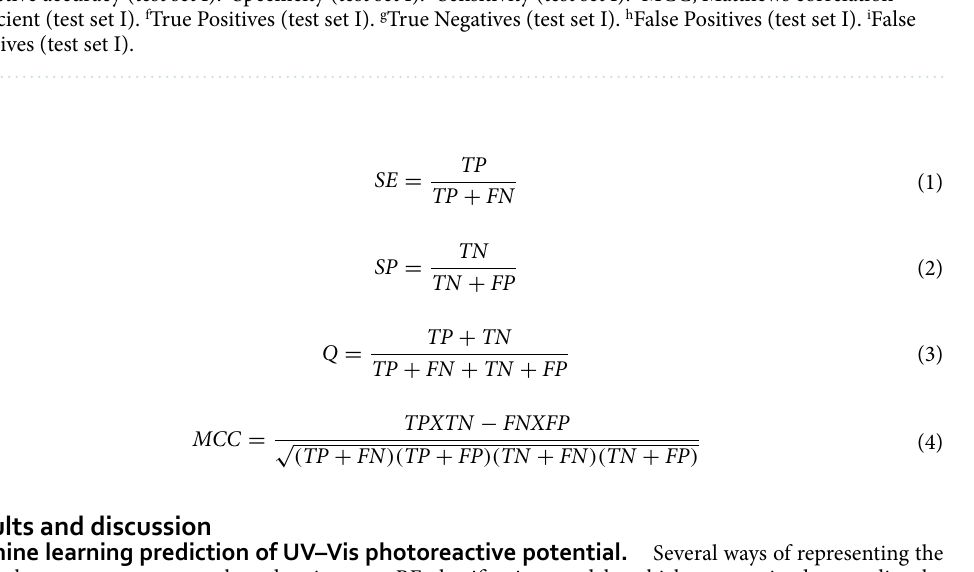
Table 3. Evaluation of different molecular descriptors and fingerprints for the prediction of UV–Vis spectrum class using the RF algorithm. a Overall predictive accuracy for the training set in OOB estimation. b